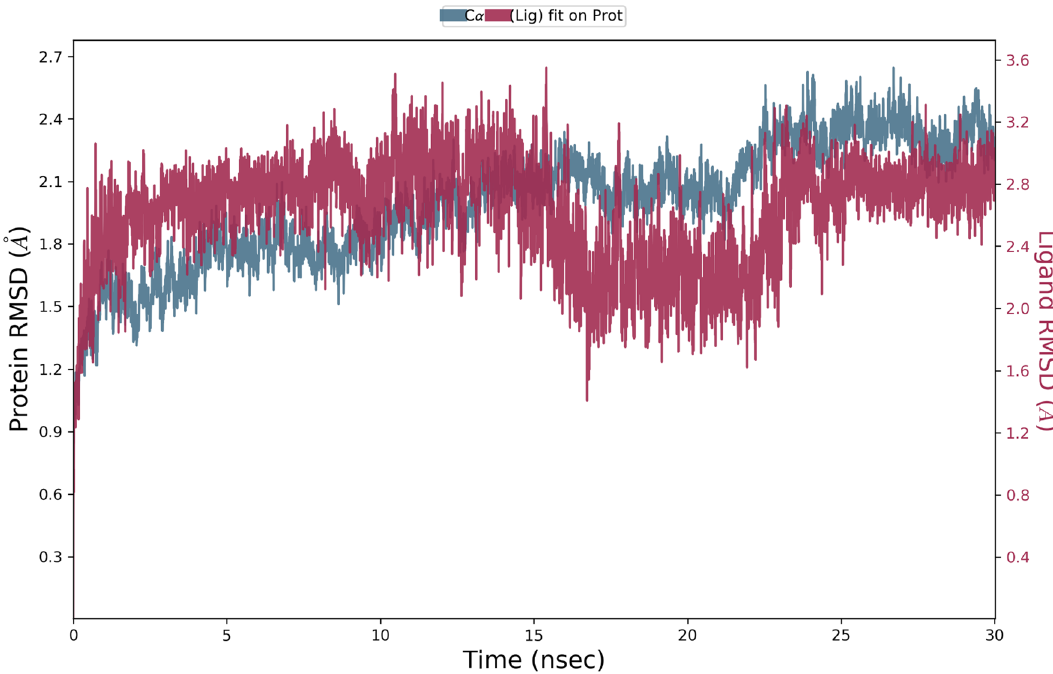
Figure 11. RMSD plot of the AChE in complex with compound 4ad in the MD simulation time. RMSD values of the Ca atoms of the protein are depicted in blue, and ligands fitted in protein are exhibited in red.